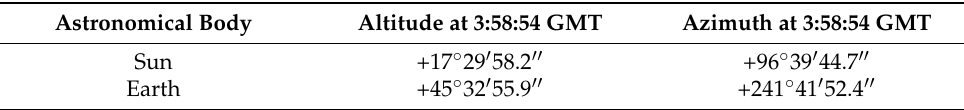
Table 1. Altitude and azimuth of Sun and Earth at the landing site of Apollo 17, at the time the photo was